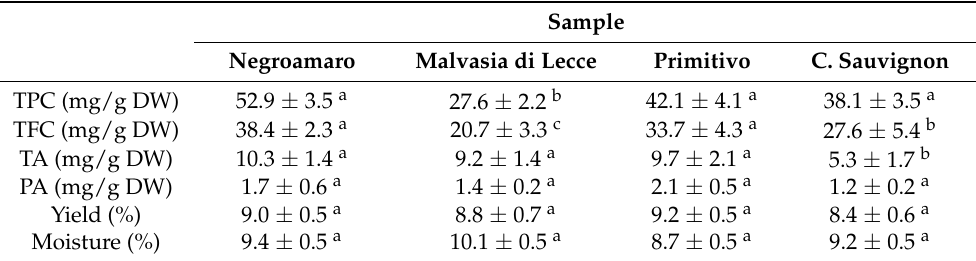
Table 1. Content of total phenolic compounds (TPC, expressed as GAE), total flavonoid compounds (TFC, as CaE), total anthocyanins (TA, as ME), proanthocyanidins (PA, CE) reported as mg/g DW. Yield and moisture (%) in grape marc extracts are